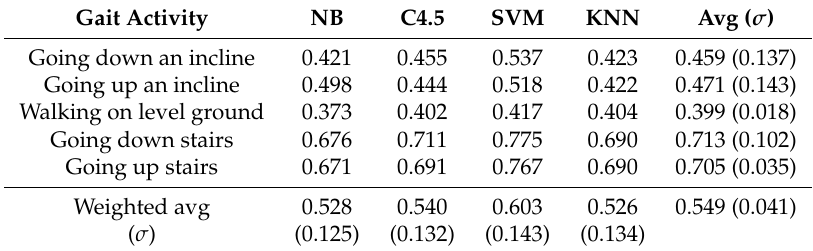
Table 4. F-measures for all gait activities using the best treatment by each classifier from sampled data (Table